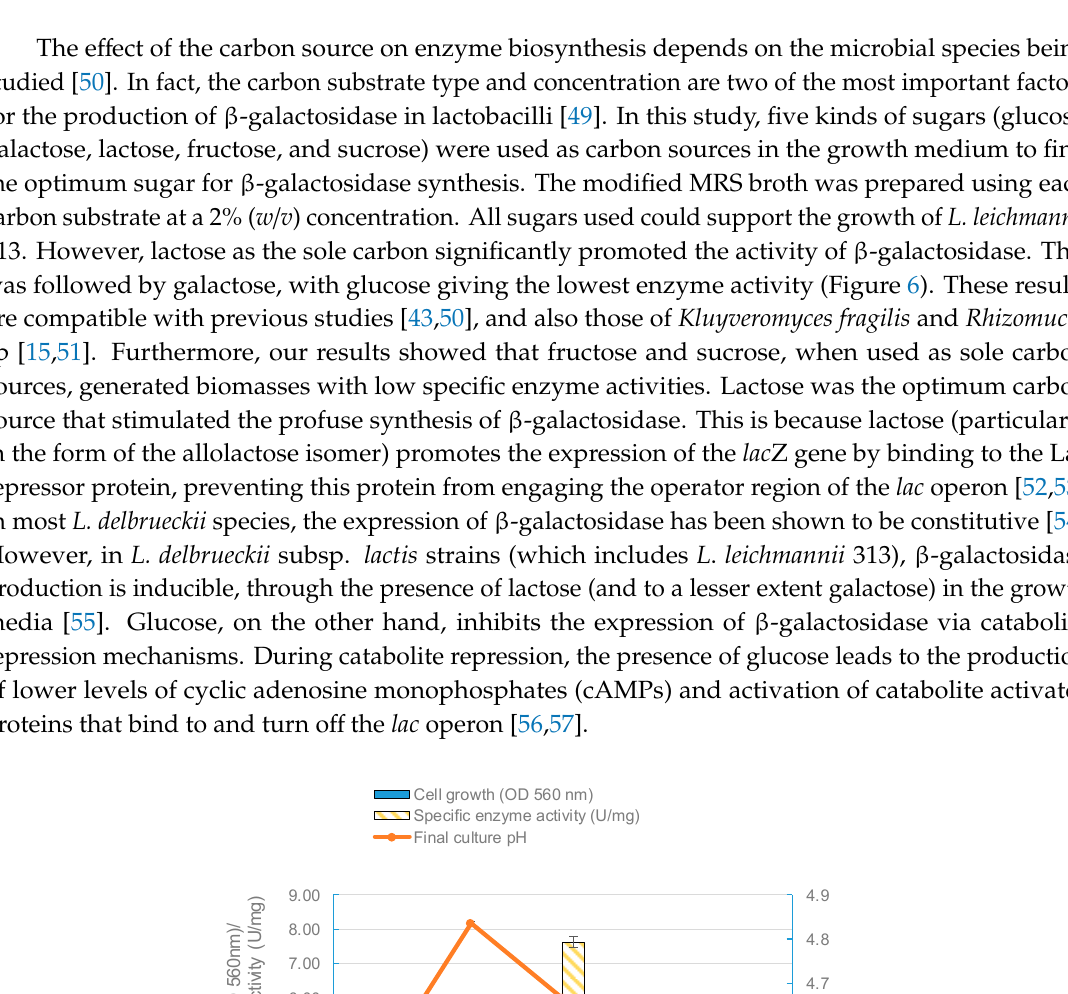
Figure 5. The effect of the initial pH on the biomass, enzyme activity, and pH. The bacteria were grown statically (0 rpm) at 37 °C in 20 mL of MRS broth placed in 30 mL capacity universal media glass bottles. Results are shown as the mean ± standard deviation of three independent experiments.